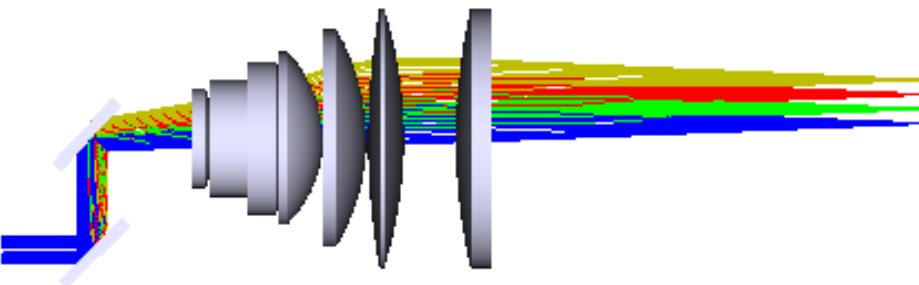
Figure 7. The three-dimensional layout of the structure of the 1D scanner uses two galvanometers in combination with the designed f-theta lens. Table 1. The design parameters of a 1D scanning system using two galvanometers .